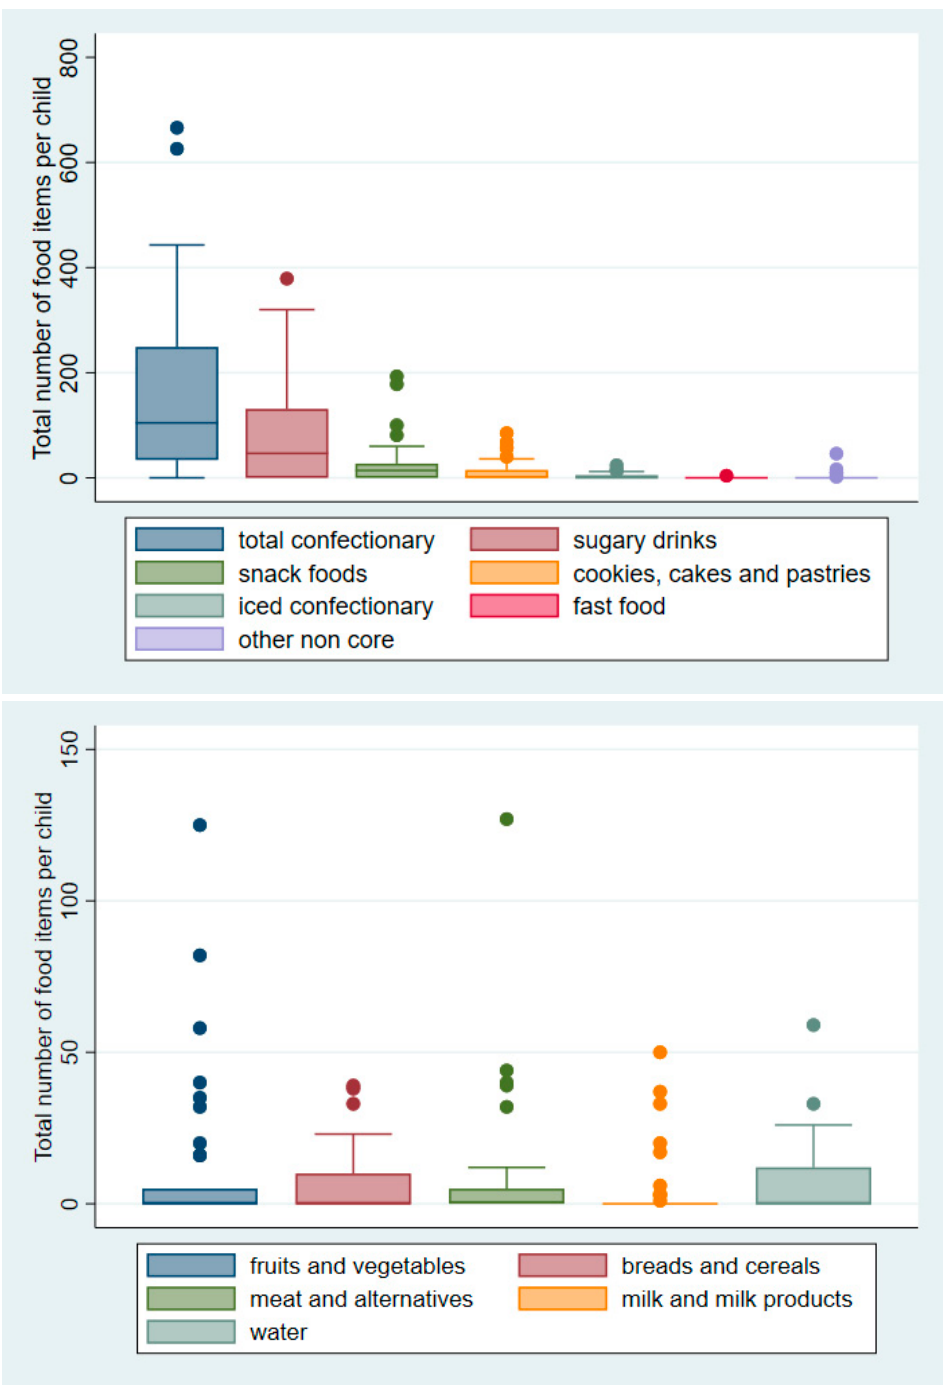
Figure 2: Median and interquartile range of noncore (top panel) and core (bottom panel) food and drink items available in convenience stores (Note the difference in axis between graphs for noncore and core food and drink. The dots represent outliers).